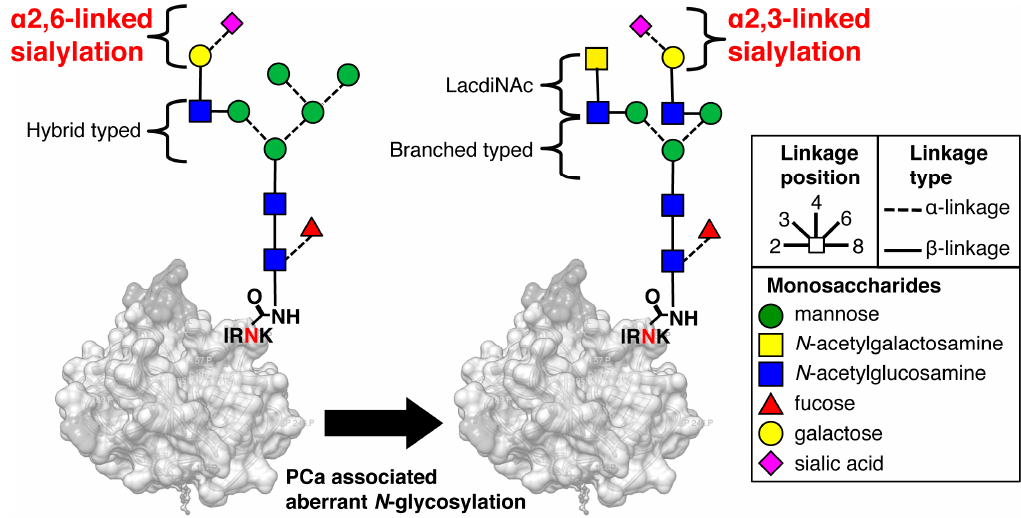
Figure 1. Prostate cancer-associated aberrant glycosylation of N -glycan on prostate-specific antigen (PSA). In normal PSA, the terminal sialic acids link to galactose residues with an α 2,6 linkage whereas in prostate cancer (PCa)-associated PSA, the linkage between the terminal sialic acid and galactose residues is an α 2,3 linkage [18]. Carbon linkage positions are denoted by the bond position drawn on each monosaccharide. Ile-Arg-Asn-Lys, (IRNK): N -glycosylation site of PSA.